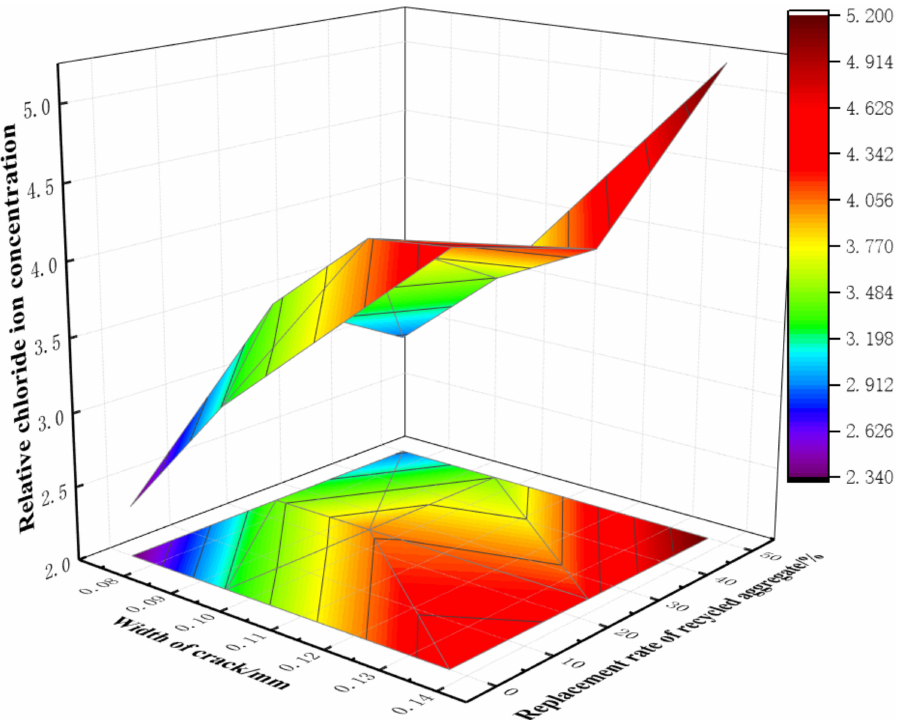
Figure 14. Distribution of relative chloride ion concentrations along with variations of crack width and replacement rate of recycled